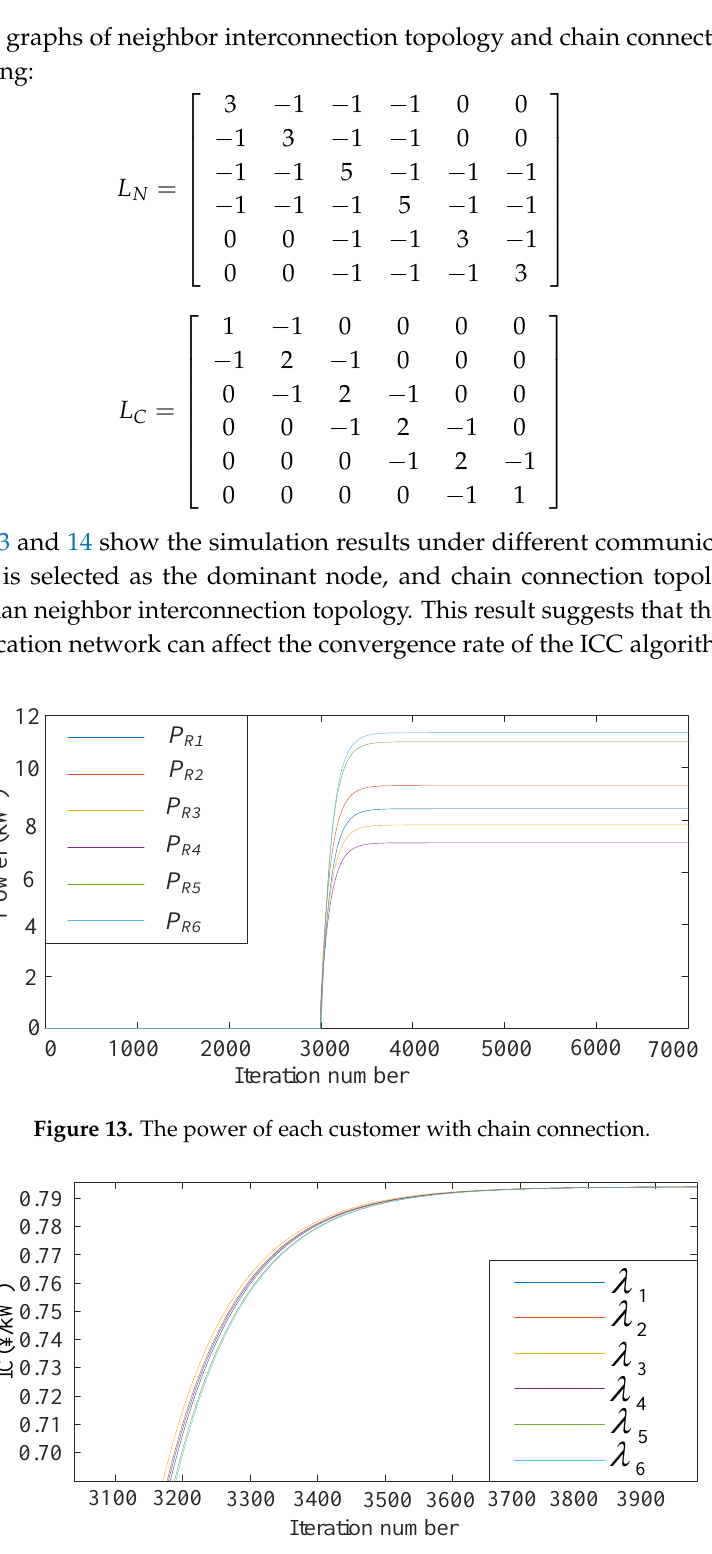
Figure 14. The IC of each customer with chain connection.